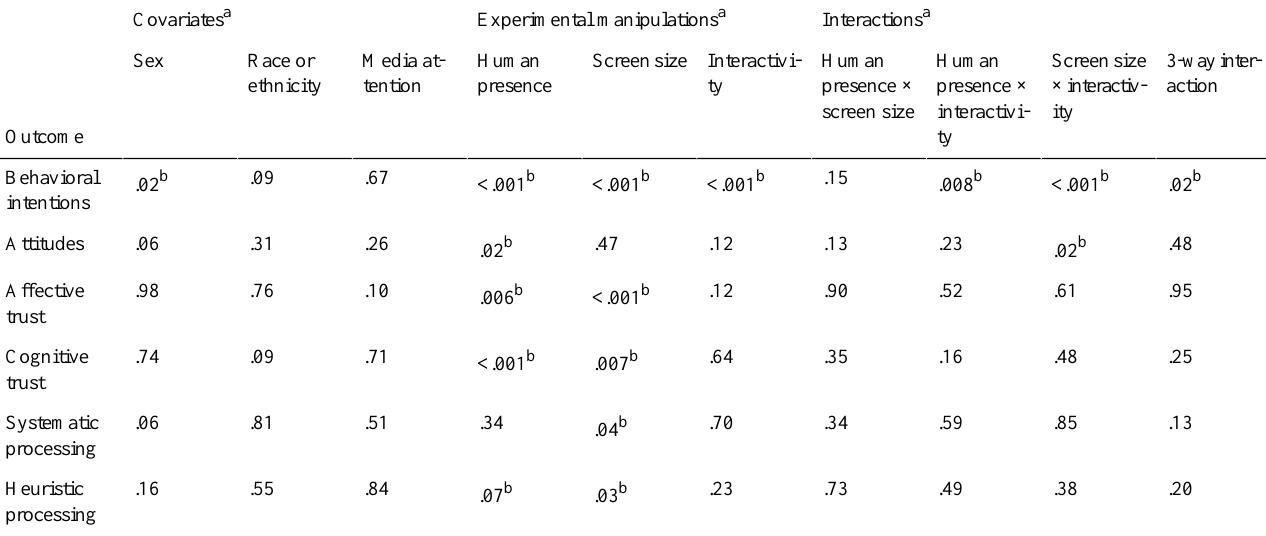
3-way inter- actionScreen size